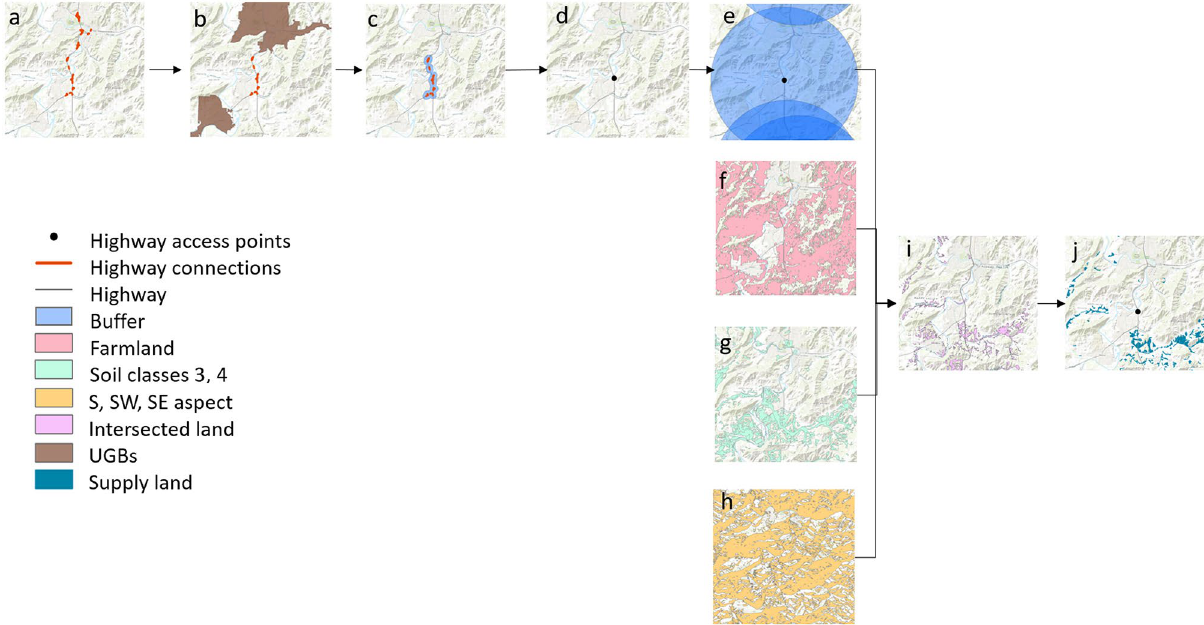
Figure 3. Analytical steps in creating land supply layer. ( a ) highway network with highway connections in orange, ( b ) urban growth boundary (UGB) polygons in brown and highway connections within UBGs erased, ( c ) dissolved 0.8 km (0.5 mi) buffer around remaining highway connections, ( d ) centroid of highway connections polygons snapped to highway to create highway access points, ( e ) 8 km (5 mi) buffer around highway access points, ( f ) farmland, ( g ) soil classes 3 and 4, ( h ) S, SW, and SE aspects, ( i ) intersection of land in ( e – h ), ( j ) final supply layer with land not suitable for AVS